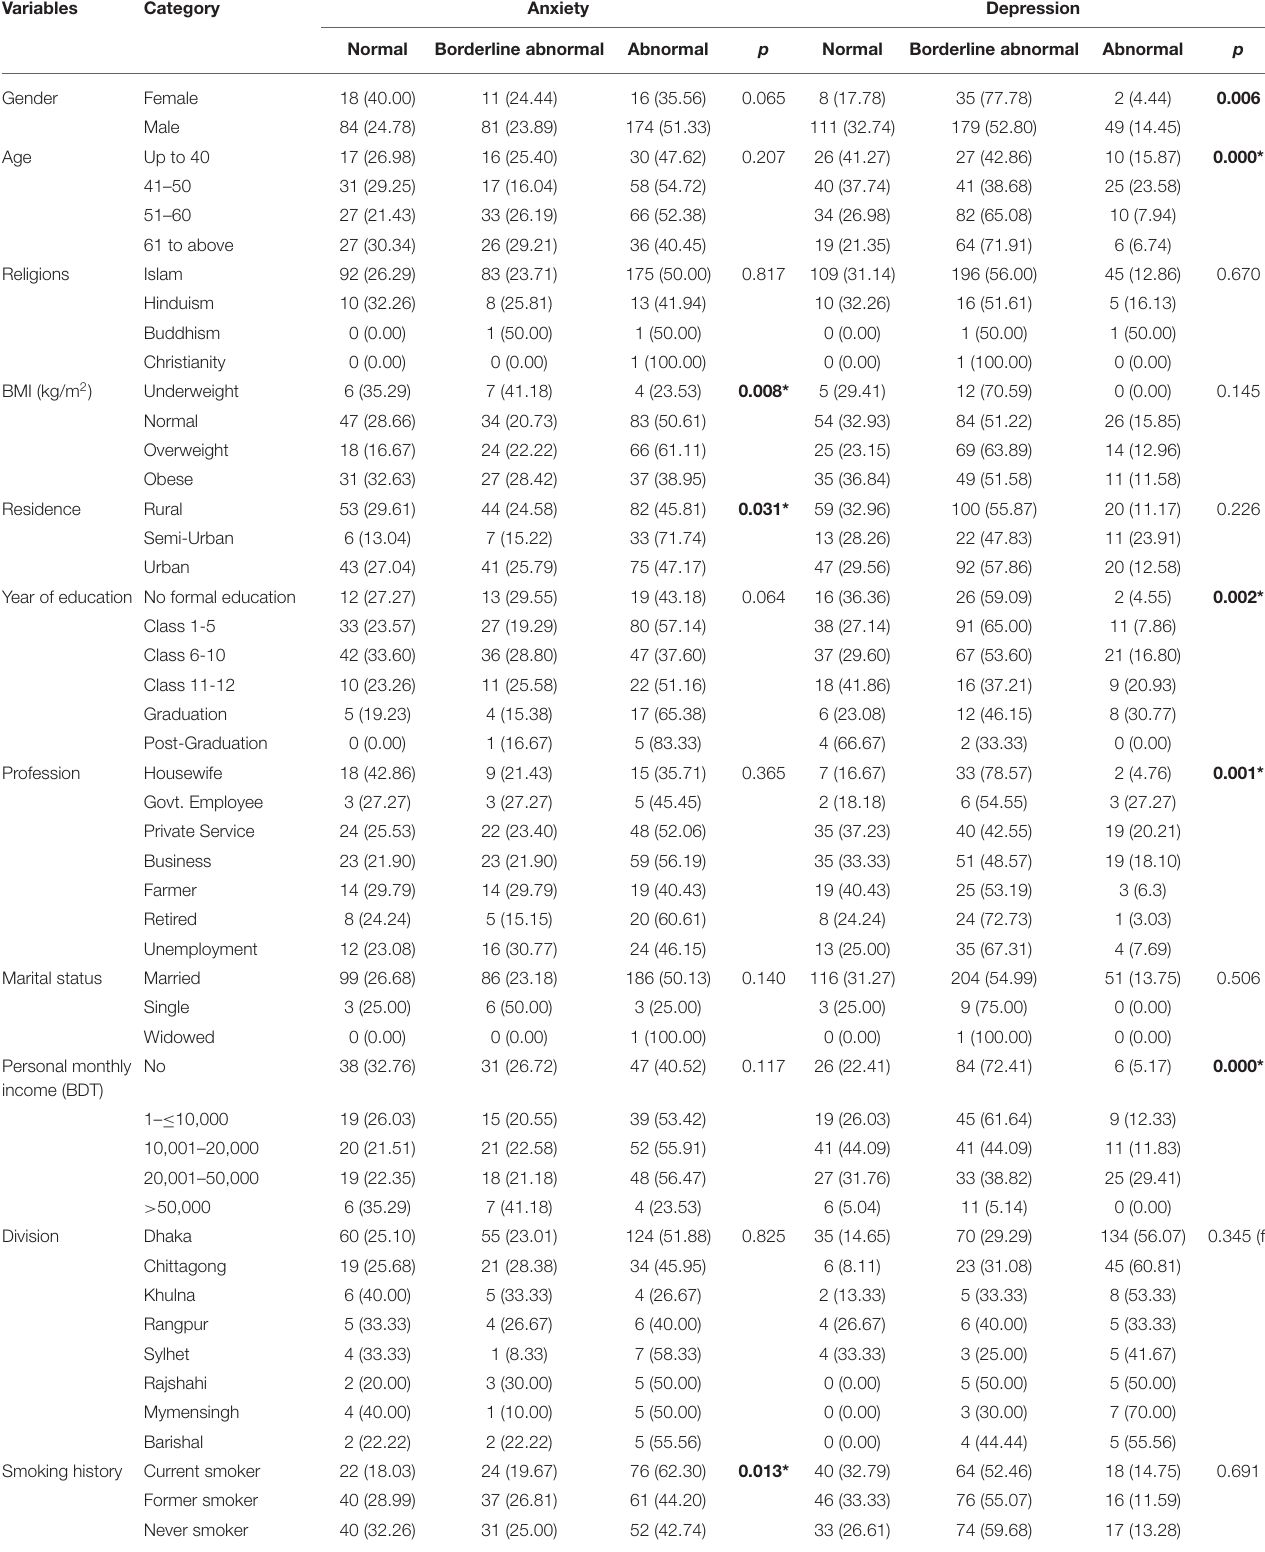
TABLE 4 | Association of the level of anxiety and depression with different